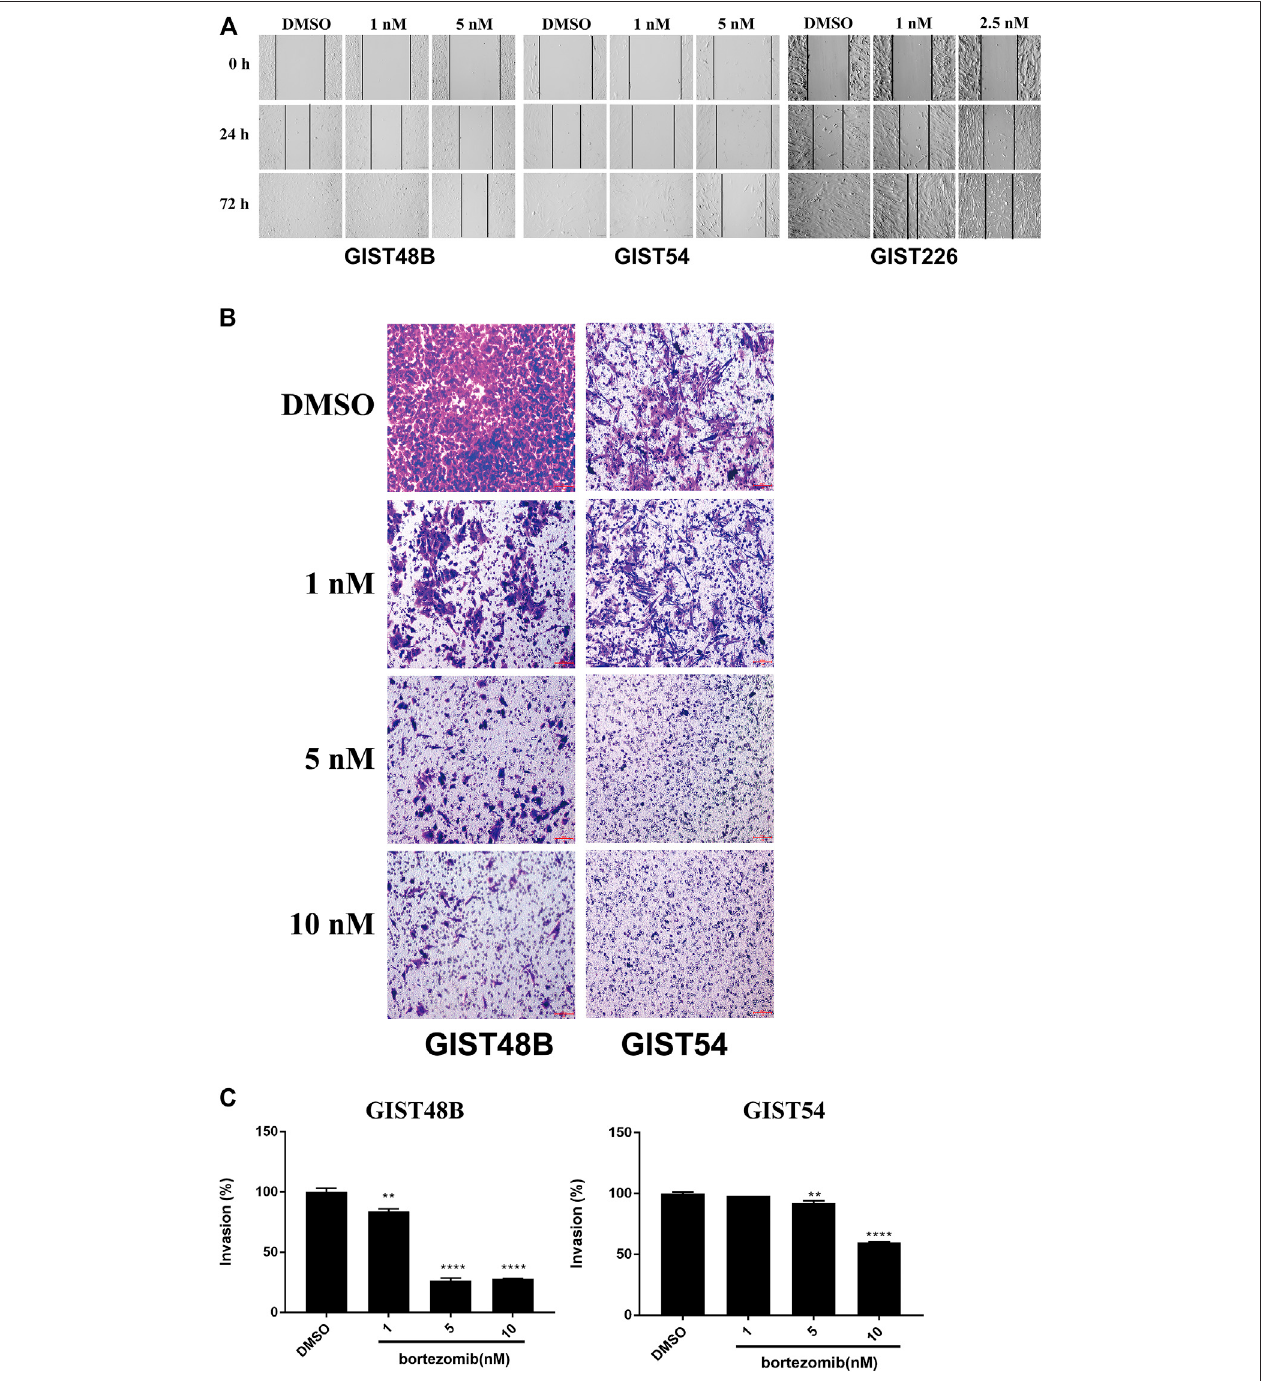
FIGURE 5 | In vitro wounding assays (A) and transwell migration assays (B) show that bortezomib treatment effectively inhibits migration and invasion of KIT- independent GIST cell lines (GIST48B, GIST54, and GIST226). Scale bars: 100 μ m. Wound healing and transwell experiments were performed in triplicate. (C) Quantitation (A 570 ) of KIT-independent GIST cell (GIST48B and GIST54) invasiveness after treatment bortezomib for 72 h. Statistically signi fi cant differences between untreated control and bortezomib treatments are presented as ** p < 0.01, **** p < 0.0001.